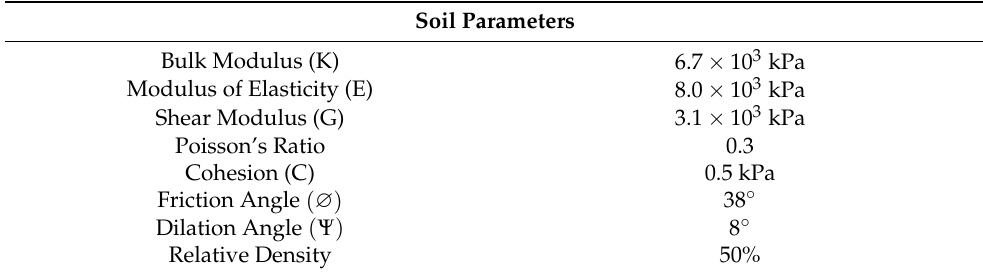
Table 1. Input parameters for sandy